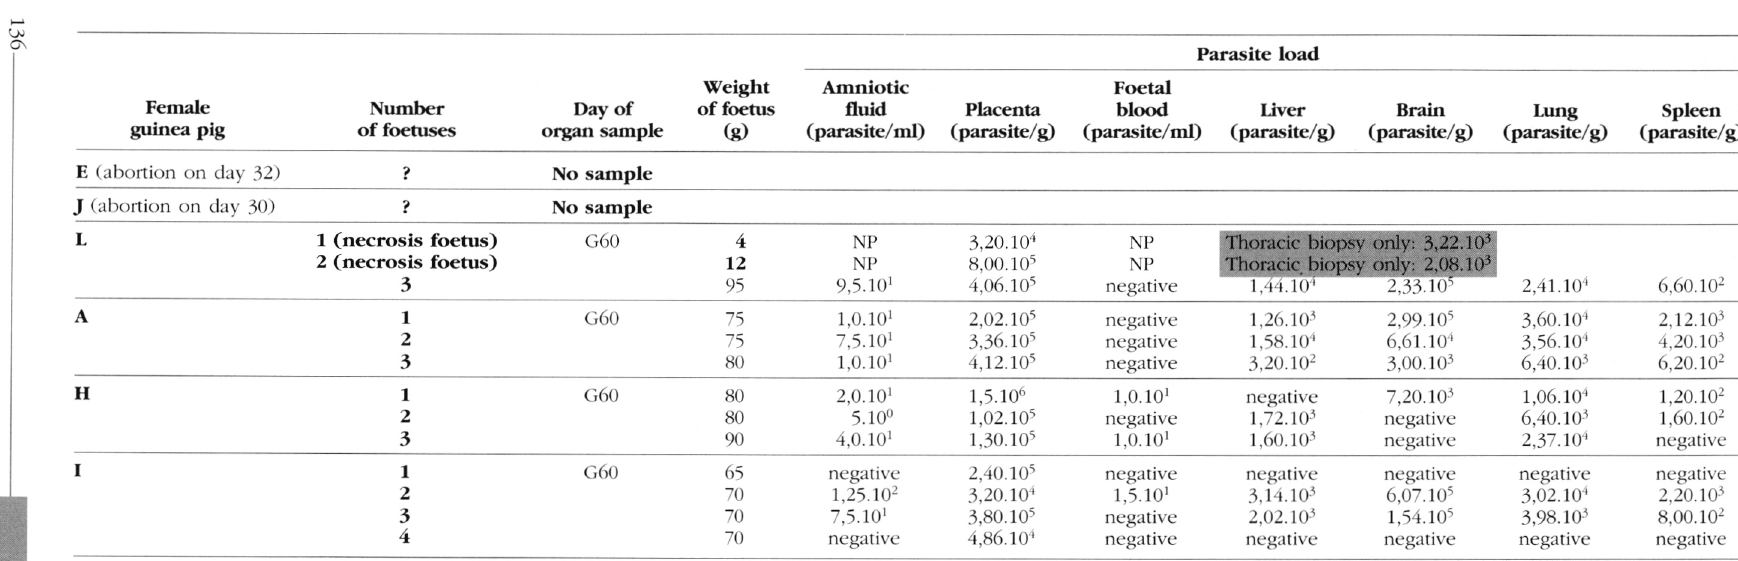
Table I. — Parasite load in different organs, amniotic fluids, and blood samples of foetuses from female guinea pigs infected on day 20 after the beginning of gestation (i.e. 40 days before the sampling of tissue on day G60).